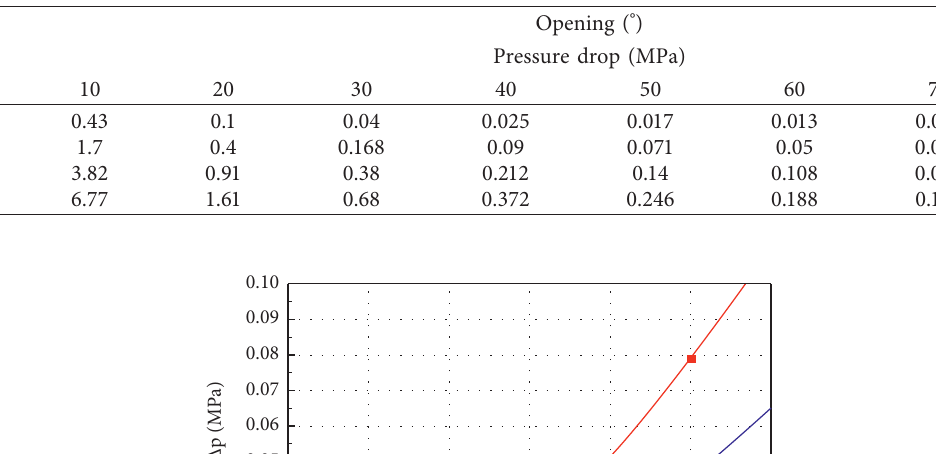
Table 3: Throttling pressure drop at different throttling openings.